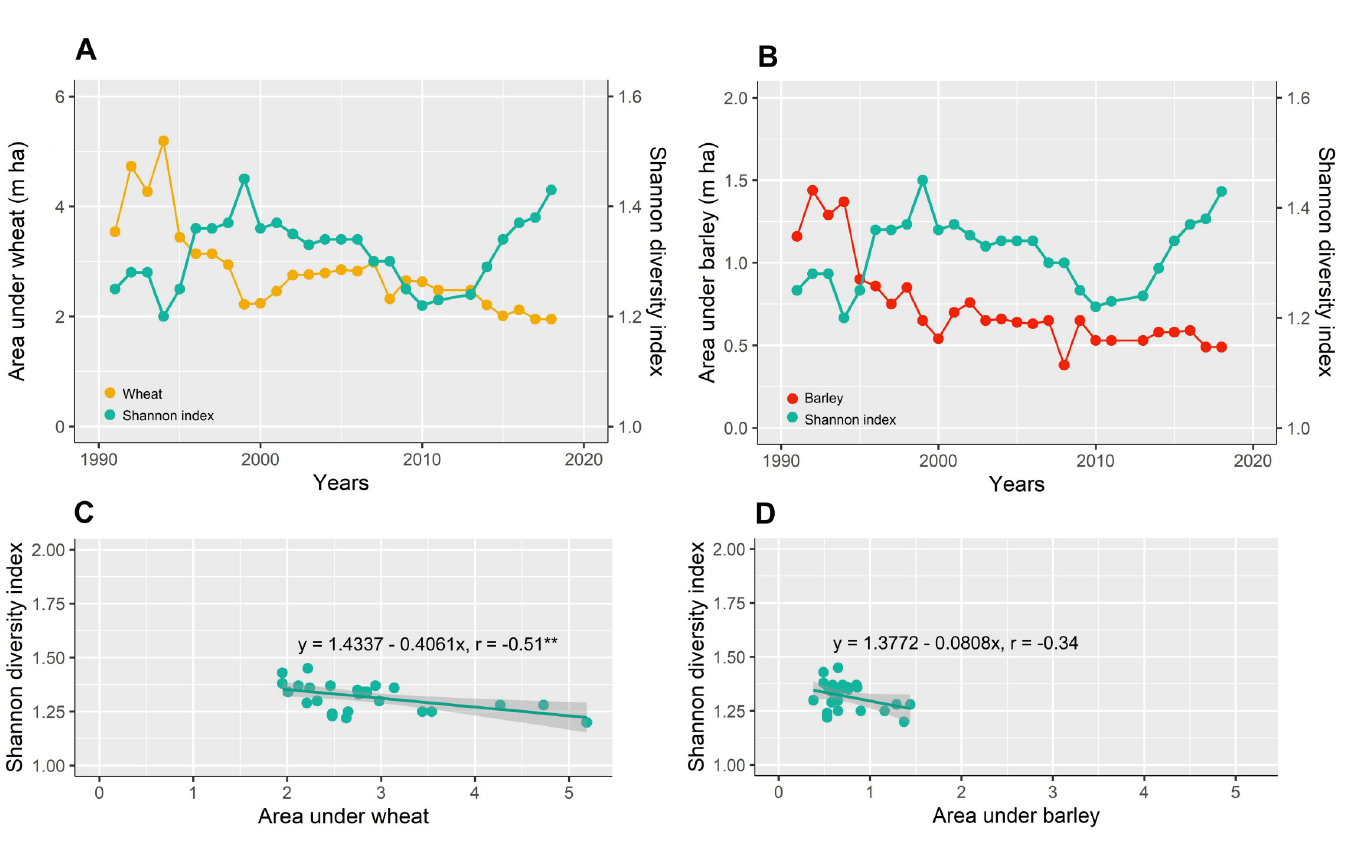
Fig 8. The trend of Shannon diversity index (H’) (A, B) and area under wheat (A) and barley (B) cultivation in Iran between 1991 and 2018. The relationship between Shannon diversity index (H’) and area under wheat (C) and barley (D) cultivation in Iran between 1991 and 2018. The solid line is the linear regression fit to the blue points (n = 28). Significant trends (p � 0.01) shown by �� . Created using ggplot2